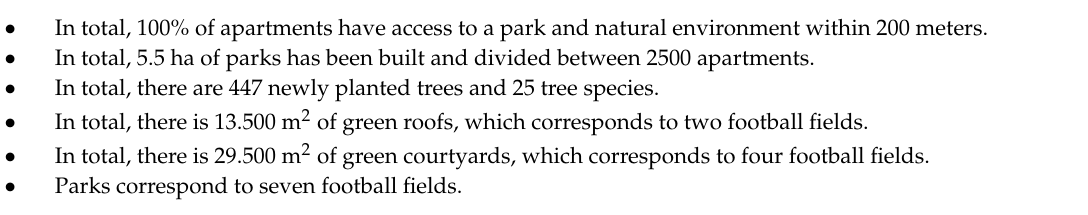
Table 6. The achieved results of the green strategy in